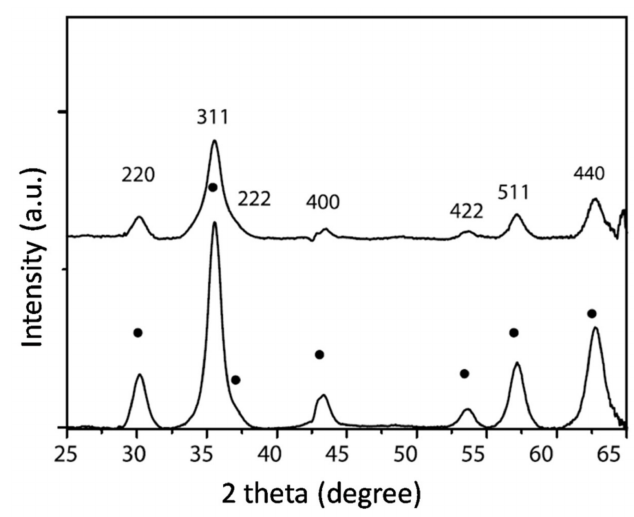
Figure 8. XRD pattern of iron oxide nanoparticles (top: 30 ◦ C and bottom: 80 ◦ C); γ -Fe 2 O 3 phase indicated by black dots. Obtained permission from Ref. [62]. Copyright 2015 Elsevier.